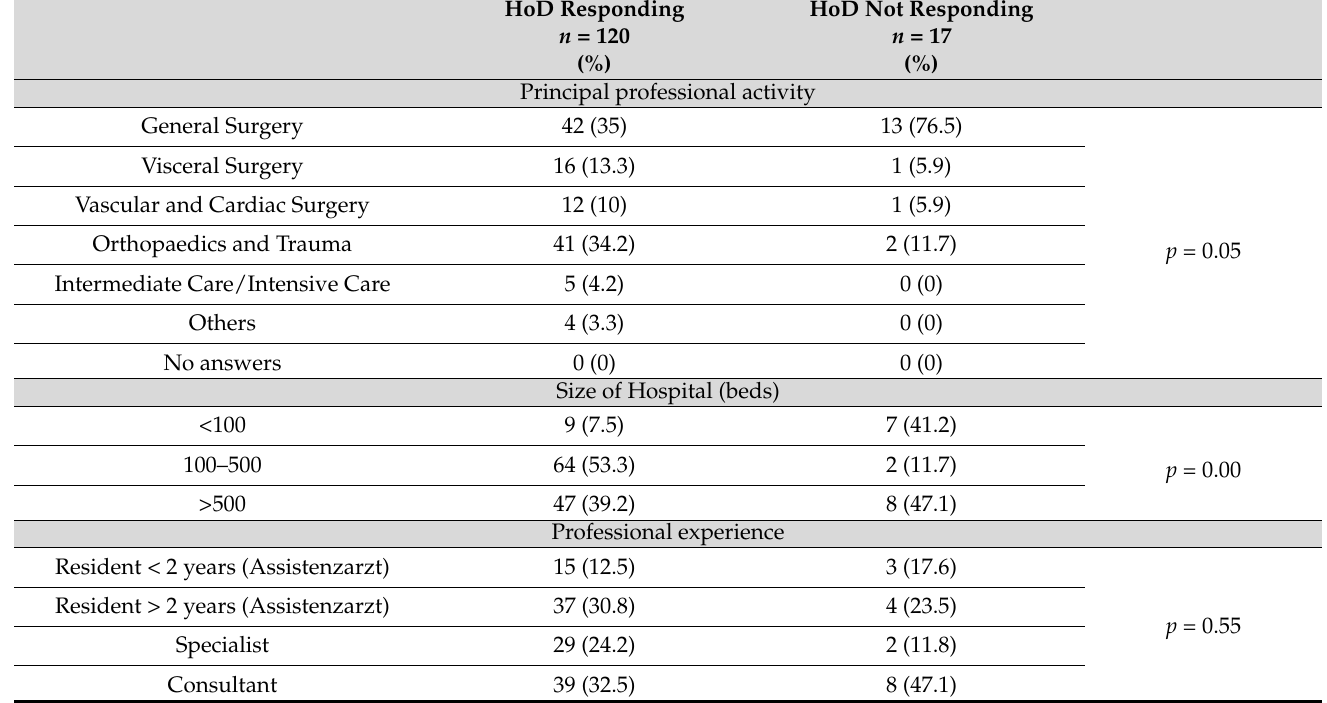
Table 2. Characteristics of MSM participating in the survey concerning principal professional activity, professional experience, and size of hospital ( n =